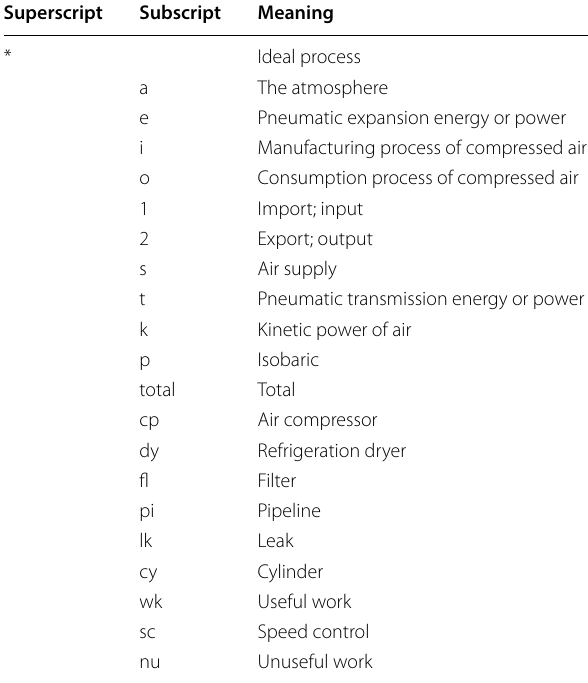
Table 2 Subscripts and